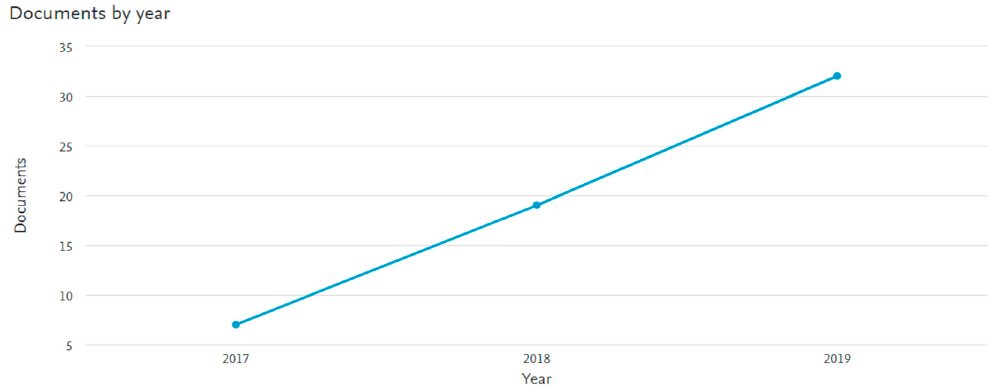
Figure 2. Scopus number of document for TITLE-ABS-KEY(agriculture AND blockchain) from 2017 to 2019.